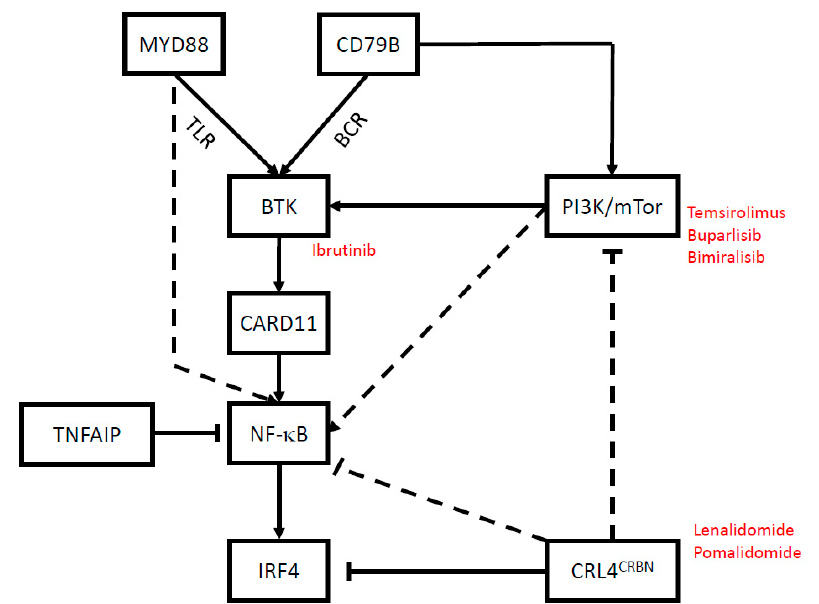
Figure 1. Schematic of oncogenic drivers of PCNSL . Small molecule inhibitors that are currently under clinical investigation for PCNSL are highlighted in red. Abbreviations: MYD88, myeloid differentiation primary response 88; BTK, Bruton's tyrosine kinase; CARD11, caspase recruitment domain-containing protein 11; TNFAIP, tumor necrosis factor (TNF)- α -induced protein; NF- B, nuclear factor kappa-light-chain-enhancer of activated B cells; IRF4, interferon regulatory factor 4; CRL4, cullin-RING E3 ubiquitin ligase 4; CRBN, cereblon; PI3K, phosphoinositide 3-kinase; mTOR, mechanistic target of rapamycin.